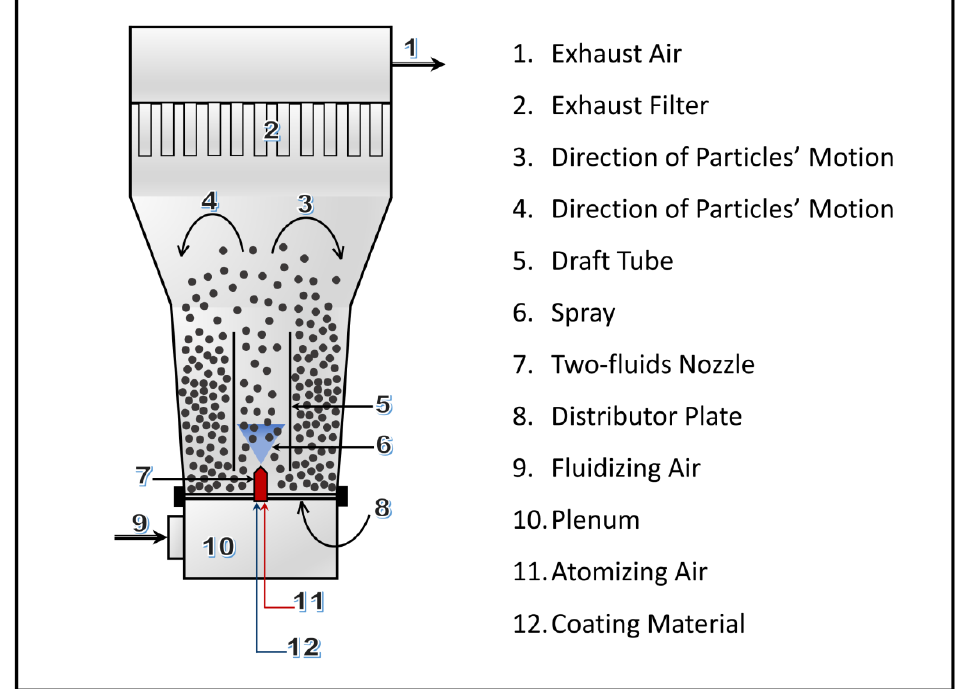
Figure 1. Schematic diagram of the Wurster fluidized-bed (WFB) reactor for urea coating. Table 1. Specifications of the Wurster fluidized-bed (WFB) reactor used in this study. Parameters